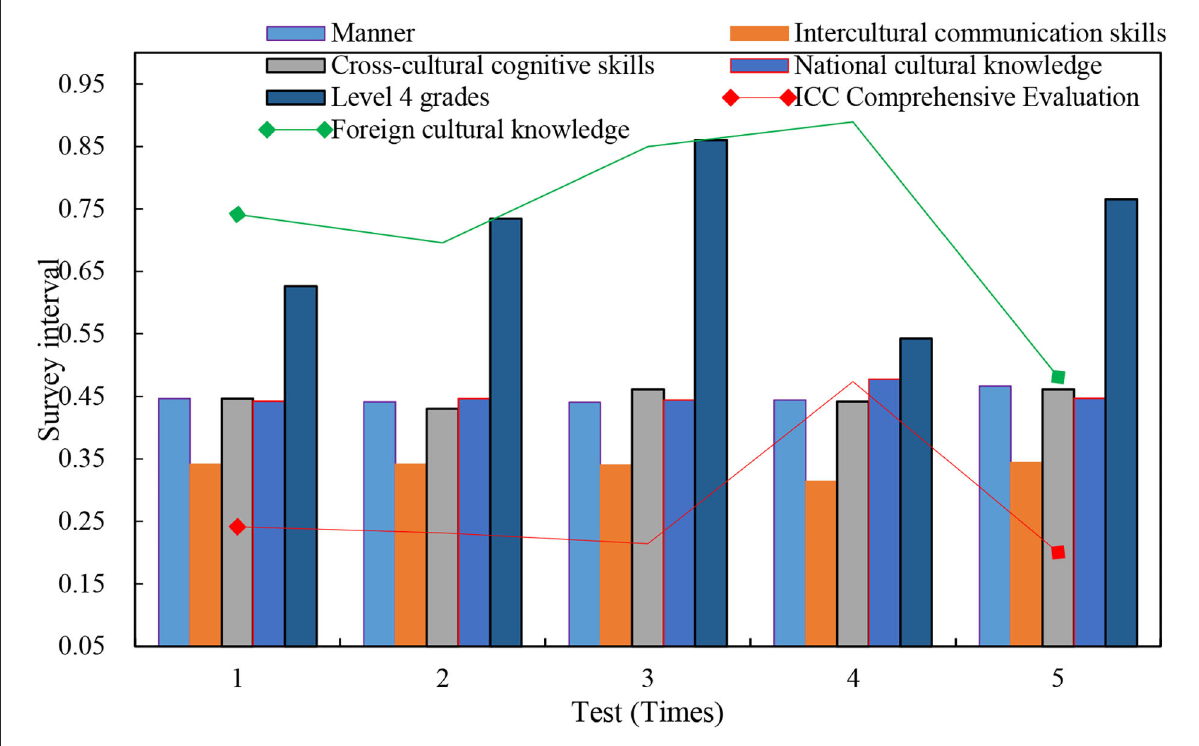
FIGURE10 Correlation between the four-level performance and its ICC individual